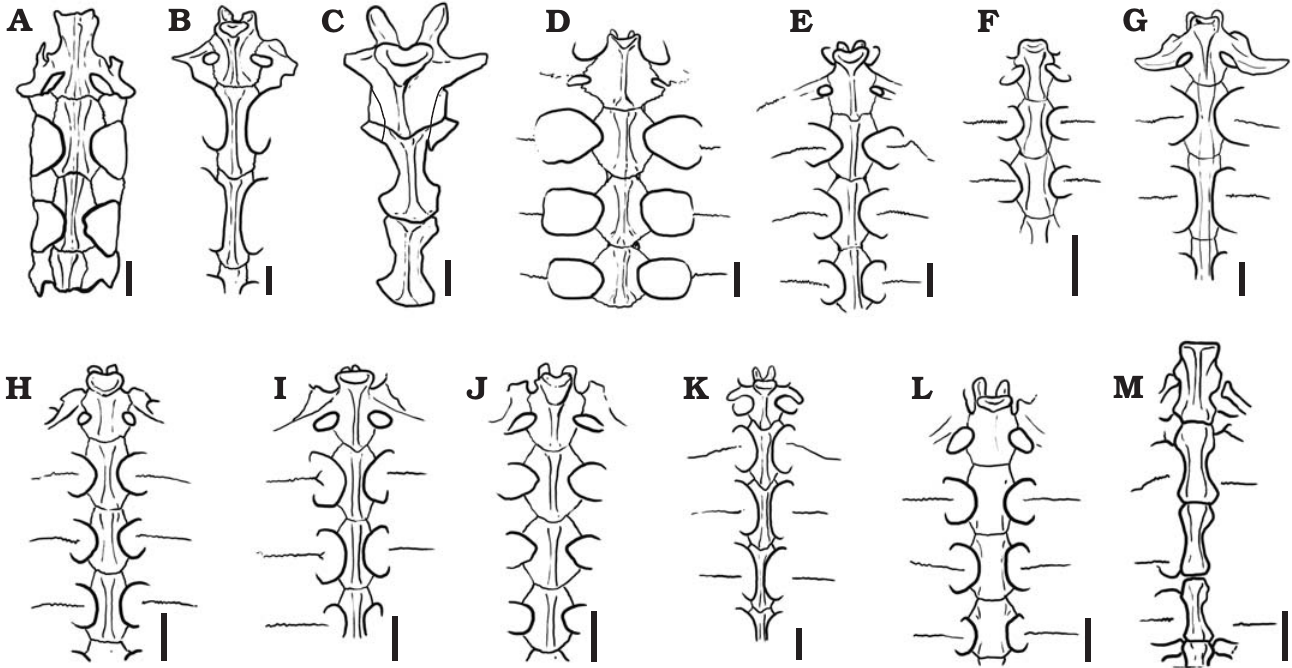
Fig. 7. Comparison of thoracic vertebrae 1–3 in some extinct and extant pleurodiran turtles. A . Chelodina colliei Gray, 1856 (NHMUK 64-12-22-66). B . Elseya dentata (Gray, 1863) (NHMUK 76-5-19-27). C . Rionegrochelys caldieroi gen. et sp. nov. (MPCA-AT 258). D . Chelus fimbriatus (Schneider, 1783) (MZUSP 2619). E . Phrynops hilarii (Duméril and Bibron, 1835) (MHNSR H-1550). F . Platemys platycephala (Schneider, 1792) (MHNSR H-1554). G . Rheodytes leukops Legler and Cann, 1980 (QMJ 7693). H . Acanthochelys macrocephala (Rhodin, Mittermeier, and McMorris, 1984) (MACN H-8288). I . Hydromedusa tectifera Cope, 1870 (MHNSR-H 1615). J . Mesoclemmys nasuta (Schweigger, 1812) (MACN H-11967). K . Podocnemis sextu- berculata Cornalia, 1849 (MZUSP 2501). L . Pelomedusa subrufa (Bonnaterre, 1789) (SMF 7953). M . Yaminuechelys gasparinii de la Fuente,